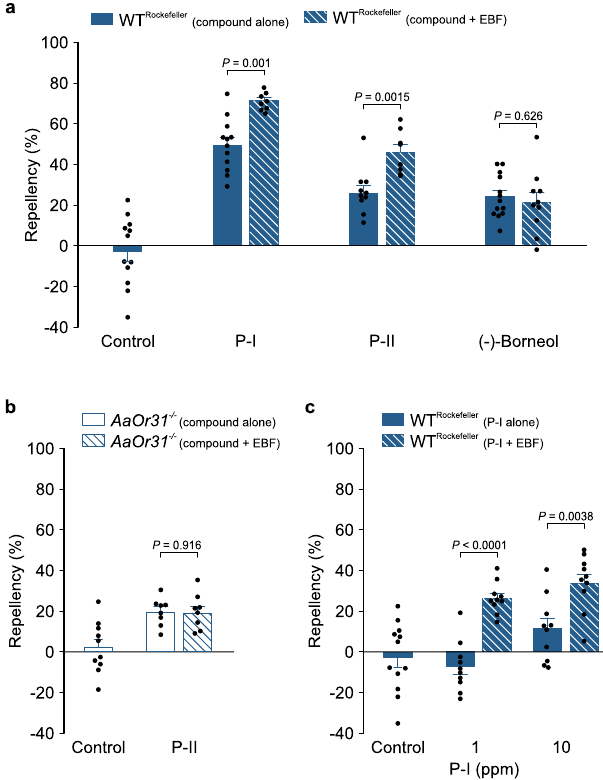
Fig. 6 Pyrethrins-induced repellency is synergized by (E)- β -farnesene (EBF) via activation of both AaOr31 and sodium channels. a Effect of EBF (4 ppm) on pyrethrin I (P-I; 1000 ppm), pyrethrin II (P-II; 1000 ppm) and (-)-borneol (100 ppm) repellency in Rockefeller ( n = 10 cages for control from 2 batches of mosquitoes; U = 6, P = 0.001 ; n = 8 cages for P-I + EBF and n = 12 cages for P-I alone from 3 batches of mosquitoes; t = 3.82, df